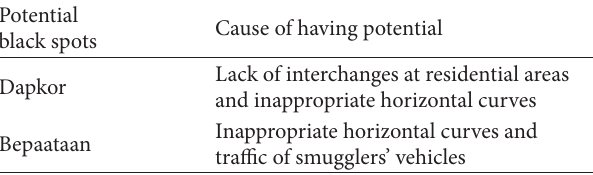
Table 4: Section 4: Sarbaaz-Pashaamag Mortaan.